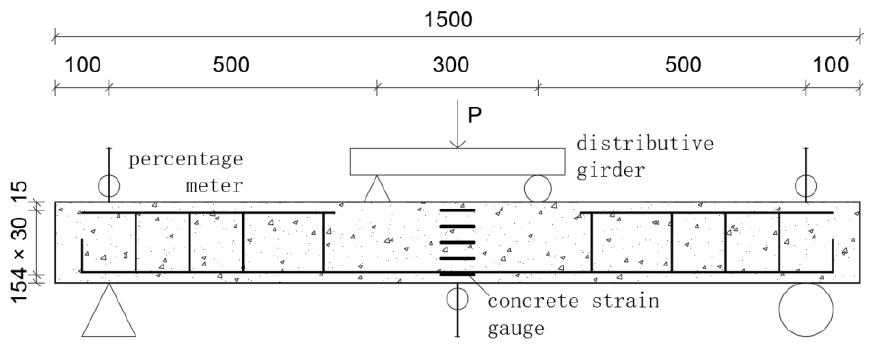
Figure 5. Diagram of static load test (unit: mm).